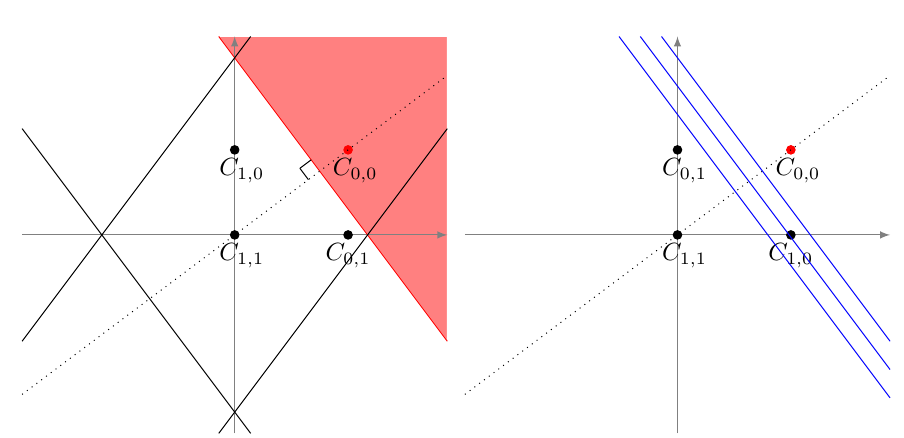
Figure 3: Centers of statistic vectors and the threshold